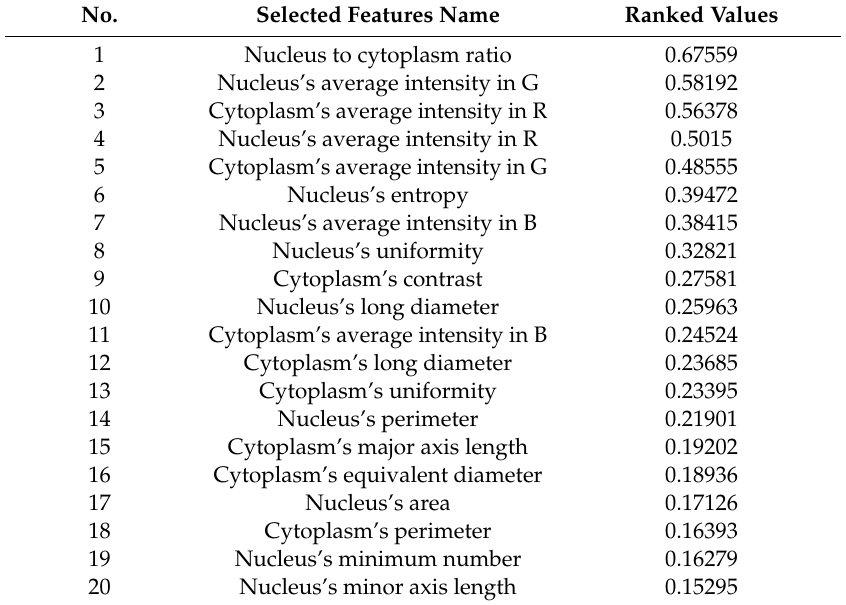
Table 12. Features’ names and their top rank attributes by random forest (RF)